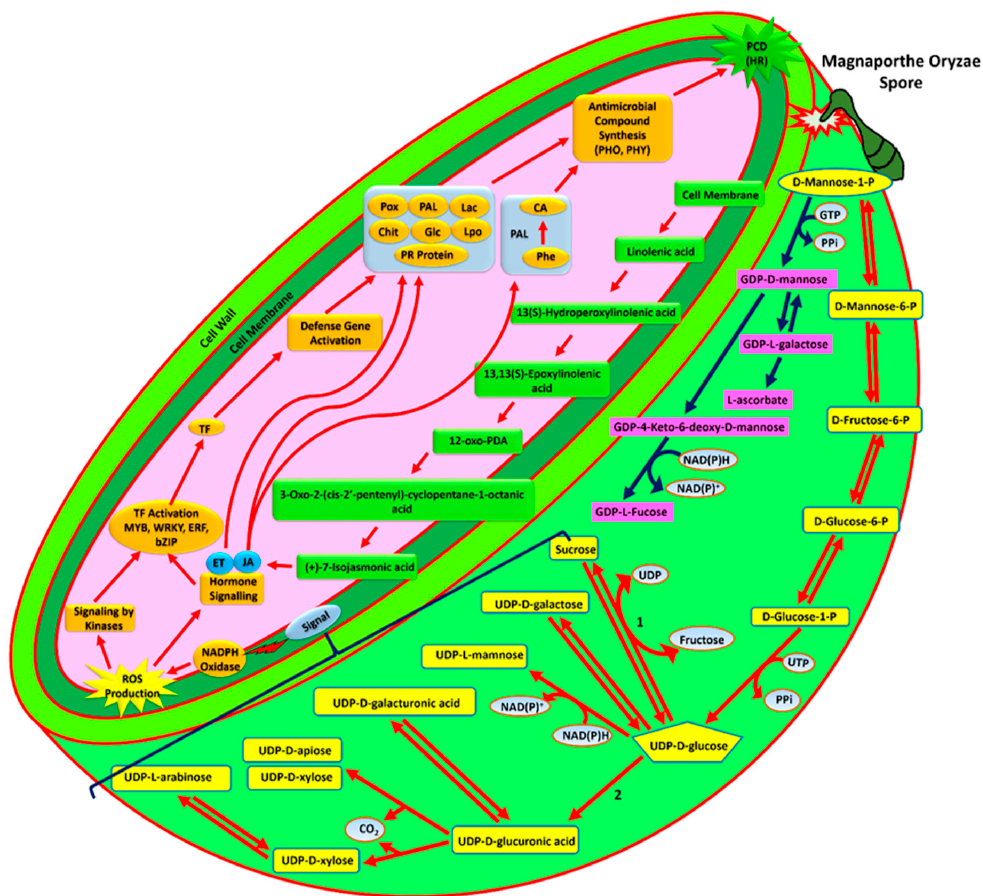
Figure 6. Overview of mechanism of rice blast resistance in Tetep at cellular level. A model to represent the resistance against M. oryzae infection in resistant rice cultivar Tetep. M. oryzae spore in the form of conidia attaches to the surface of tissue using a hook like structure and grows a germ tube to penetrate inside the epithelial cell layer. This stimulus triggers a cell wall precursor synthesis pathway leading to generation of two NADPH molecules and their subsequent oxidation for ROS production. This activates the kinase and hormone signaling molecules. Simultaneously, jasmonic acid production starts at the cell membrane of infected cells that triggers downstream hormone signaling. Kinase signaling molecules activate transcription factors (bZIP, MYB, WRKY). Altogether, it results in expression of defense related genes like Pox, Pal, Lac, Chit, Glc, Lpo leading to synthesis of PHY and PHO type of antimicrobial compounds that responds to M. oryzae growth on the cell wall. Abbreviations: GTP, Guanosine-5’-triphosphate; UDP, Uridine diphosphate; UTP, Uridine-5’-triphosphate; PPi, Pyrophosphate; NADP + , Nicotinamide adenine dinucleotide phosphate; CO2, Carbondioxide; ROS, reactive oxygen species; HR, hypersensitive response; PCD, programmed cell death; TF, transcription factor; ET, ethylene; JA, jasmonic acid; PR proteins, pathogenesis-related proteins; CA, cinnamic acid; PAL, phenylalanine ammonia lyase; Glc, glucanases; Chit, chitinases; LPO, lipoxygenases; POX, peroxidases; Lac, laccases; PHO, phenolics; PHY, phytoalexin. Symbols: 1, UDP-glycosyltransferase; 2, UDP-glucose 6-dehydrogenase .